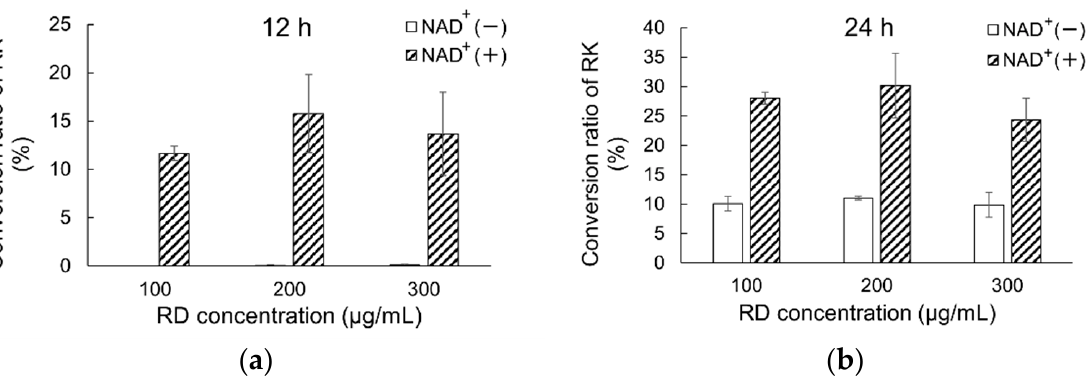
Figure 2. Comparison of metabolism of RD to RK in human skin homogenates exposed to different RD concentrations in the presence or absence of NAD + (( a ): after 12 h; ( b ): after 24 h). RK conversion rates after application of different RD doses (final concentration: 100, 200, or 300 µ g/mL) in the presence or absence of NAD + . Data are presented as means ± standard deviation (n = 3). Concentrations of RK were converted to percentages for clarity; RD, rhododendrol; RK, raspberry ketone. The consumption of RD enantiomers was also examined at different concentrations